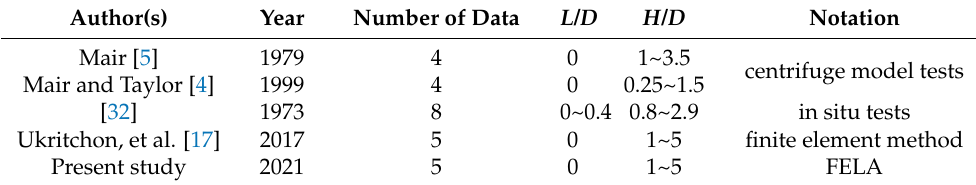
Table 2. Database of the tunnel stability number (0 ≤ L / D <